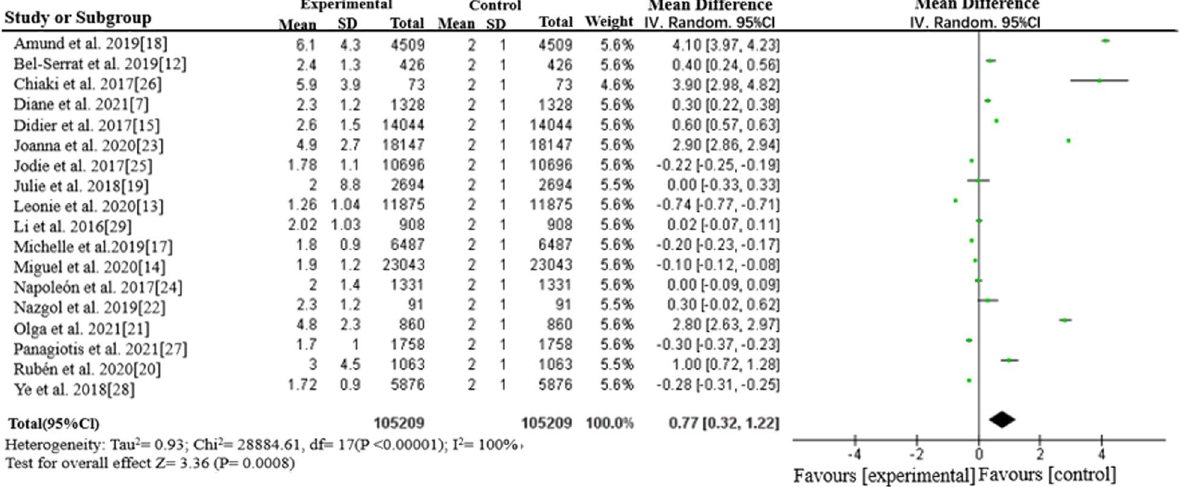
types of screen viewing of school-aged children. The home setting, especially parents, plays a vital role in deciding the type and length of screen viewing. Par-